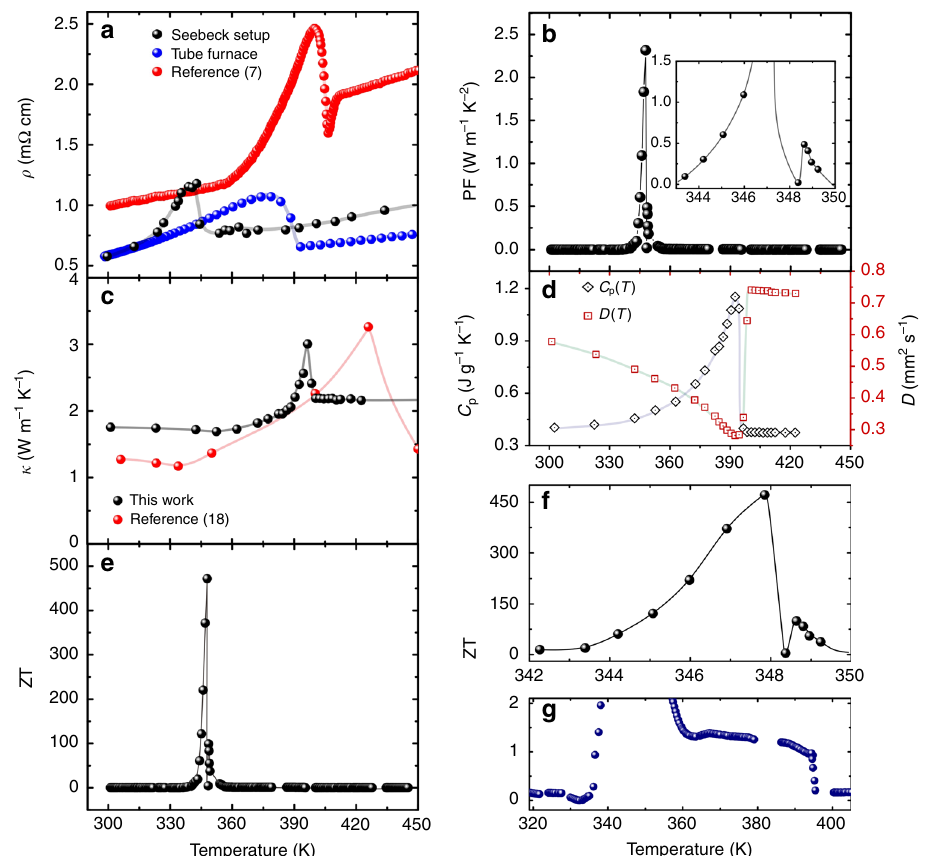
Fig. 4 Temperature dependences of thermoelectric properties of Cu 2 Se. a Electrical resistivity, ρ , together with the reference data of the nominal composition Cu 2 Se 7 . b Power factor, PF, displaying two peaks related to negative and positive S ( T ). c Thermal conductivity, κ , and reference data 18 . d Speci fi c heat, C p , together with the thermal diffusivity, D . e Dimensionless fi gure of merit ZT. f Region of abnormal behavior in ZT temperature dependence showing two peaks. g The plateau observed in ZT temperature